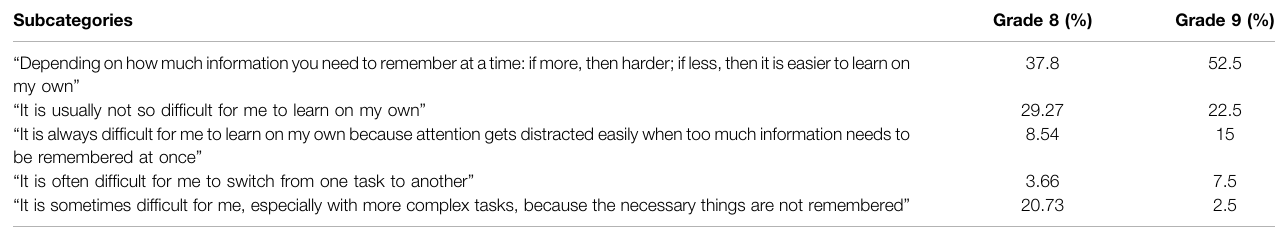
TABLE 6 | Respondings to the question “ how do you usually feel about learning on your own? ” by grades. Subcategories